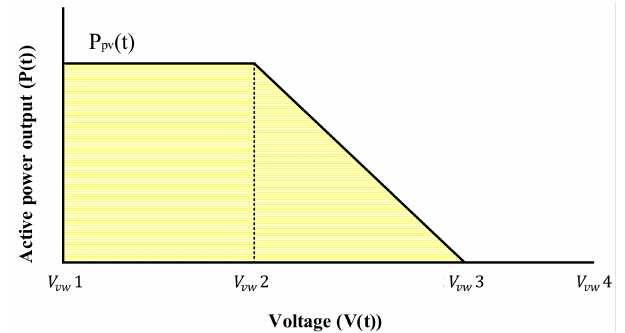
Figure 1. Volt–Watt curve